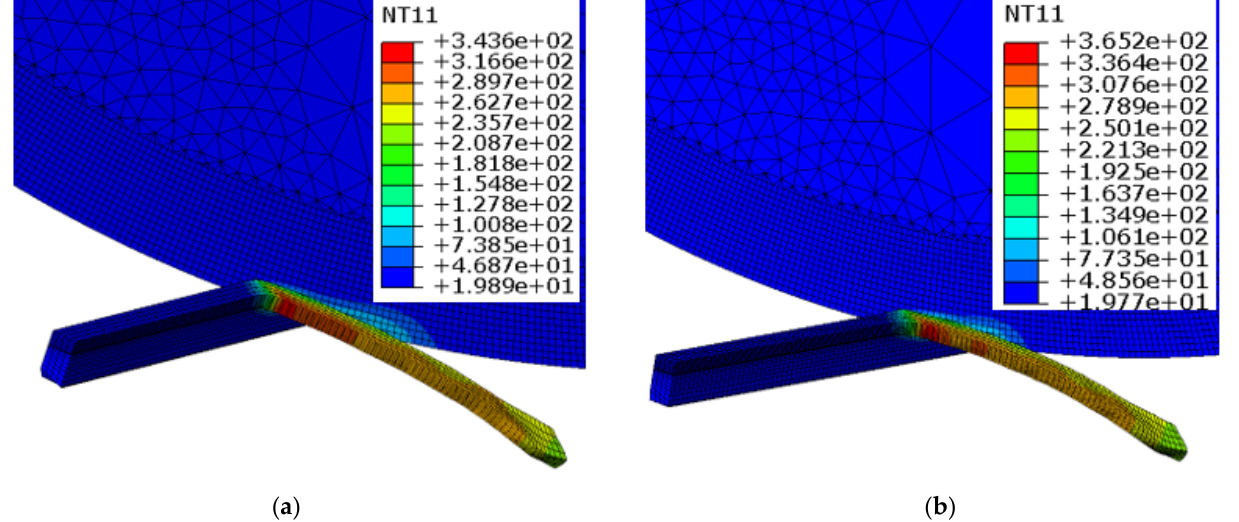
Figure 6. Chip formation and temperature contours for SPRT and workpiece at different cutting